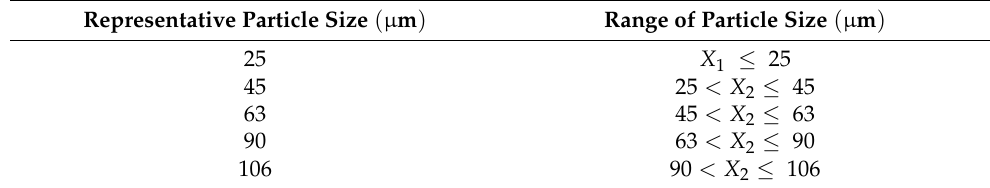
Table 1. Particle size distribution. Representative Particle Size ( µ m